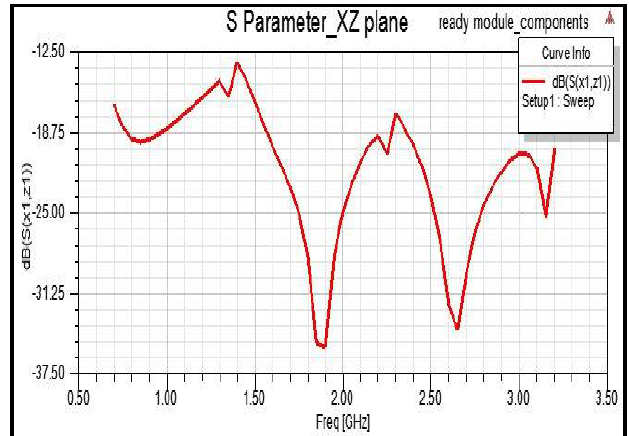
Figure 6: Proposed HFSS module of 3-Axis crossed dipole array.